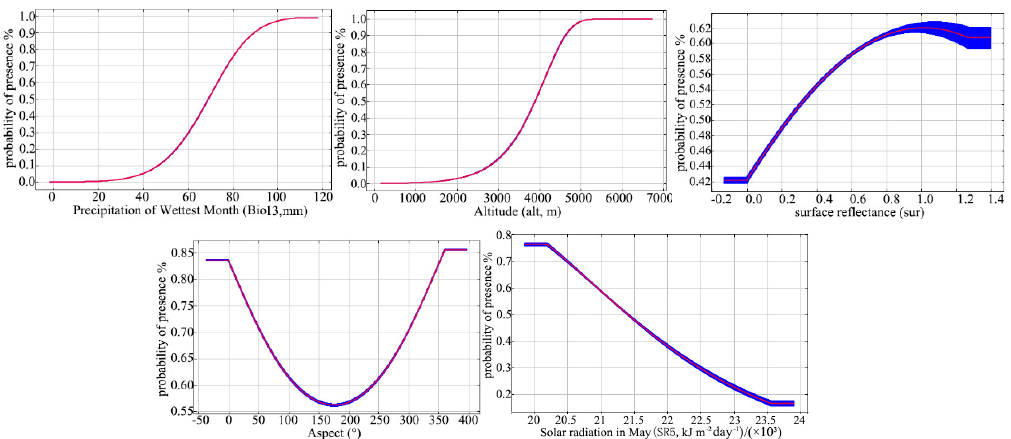
Figure 7. Response curves of geographical environment factors in the glacier suitable habitat.